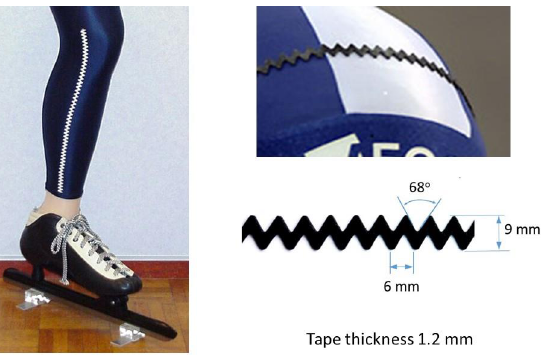
Figure 1. The foam zigzag tape for the lower legs and cap introduced at the 1998 Nagano Olym- pics .